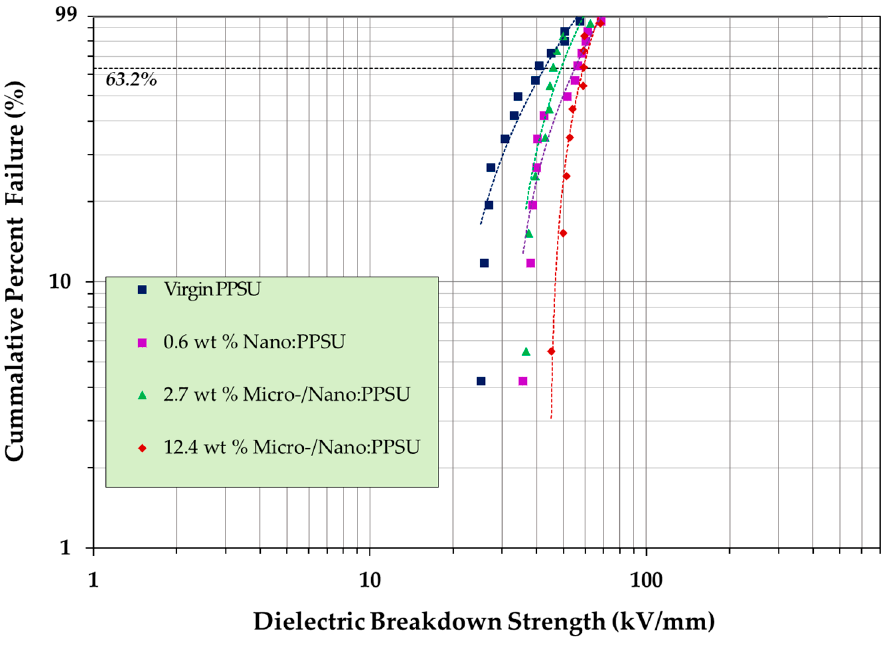
Figure 8. Weibull distribution plot of PPSU and PPSU/h-BN composites.